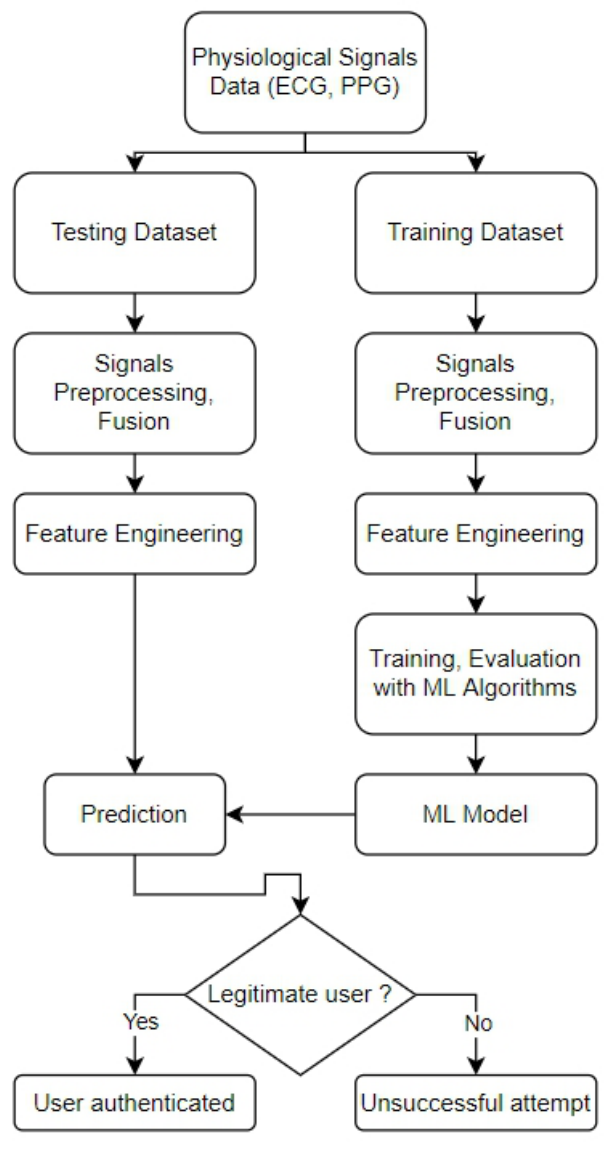
Figure 9. The workflow of creating ML-based authentication